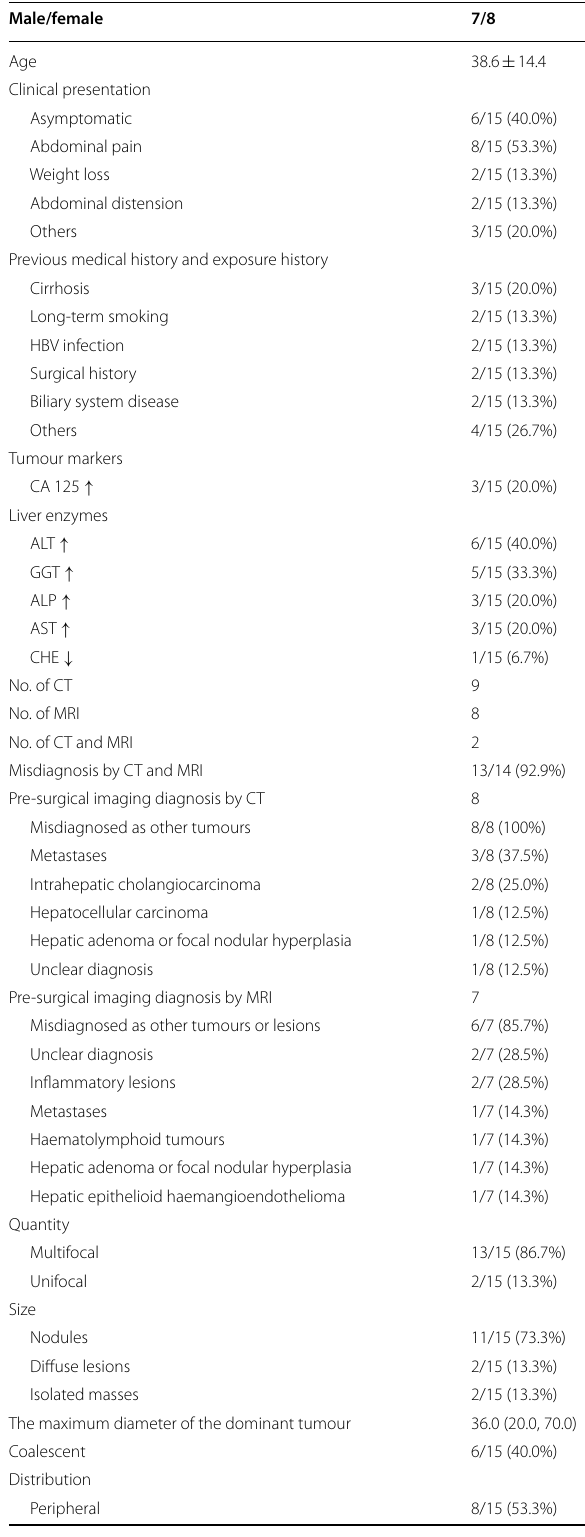
Table 1 Summary of clinical, histological and imaging characteristics of 15